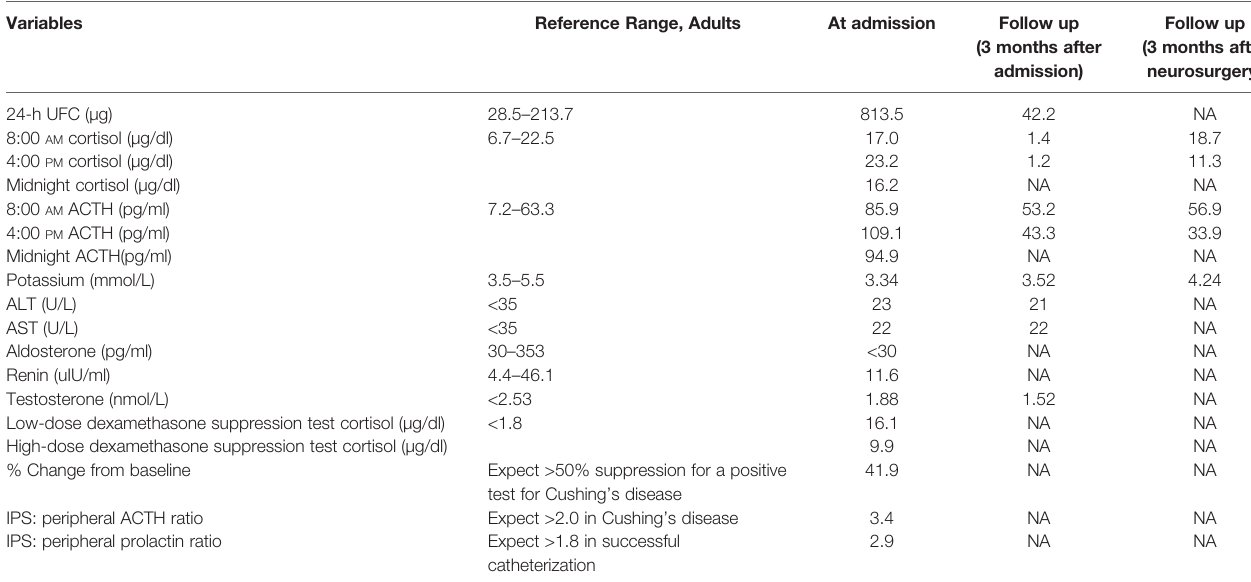
TABLE 1 | Laboratory data.